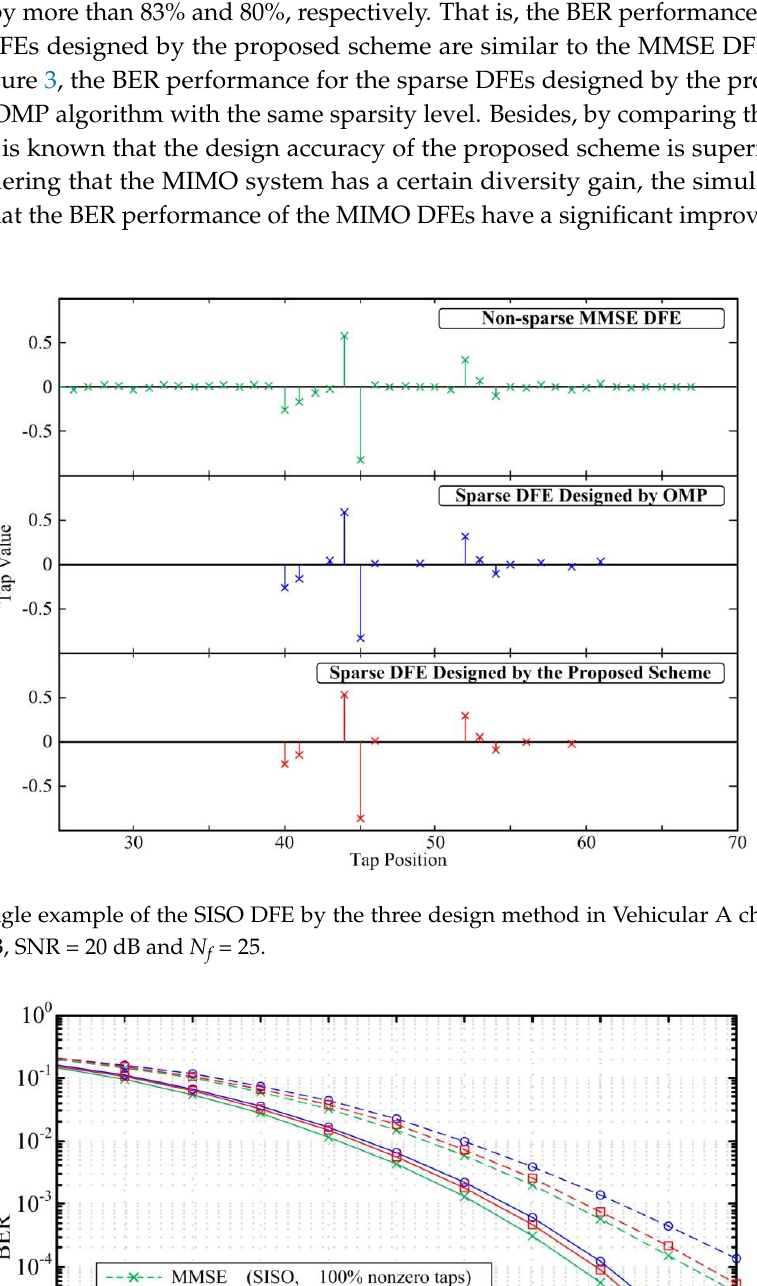
Figure 4. NMSE versus SNR for SISO DFE and MIMO DFE in the Vehicular A channel with max η = 0.6 dB and N f = 50. To verify the performance of the proposed scheme in different channels, Figures 5 and 6 show the simulation results in the exponential decay channel. Comparing with the OMP method, the results also show that the proposed scheme has better BER performance and smaller NMSE with the same sparsity level. Therefore, the proposed scheme provides excellent performance in different channel conditions.